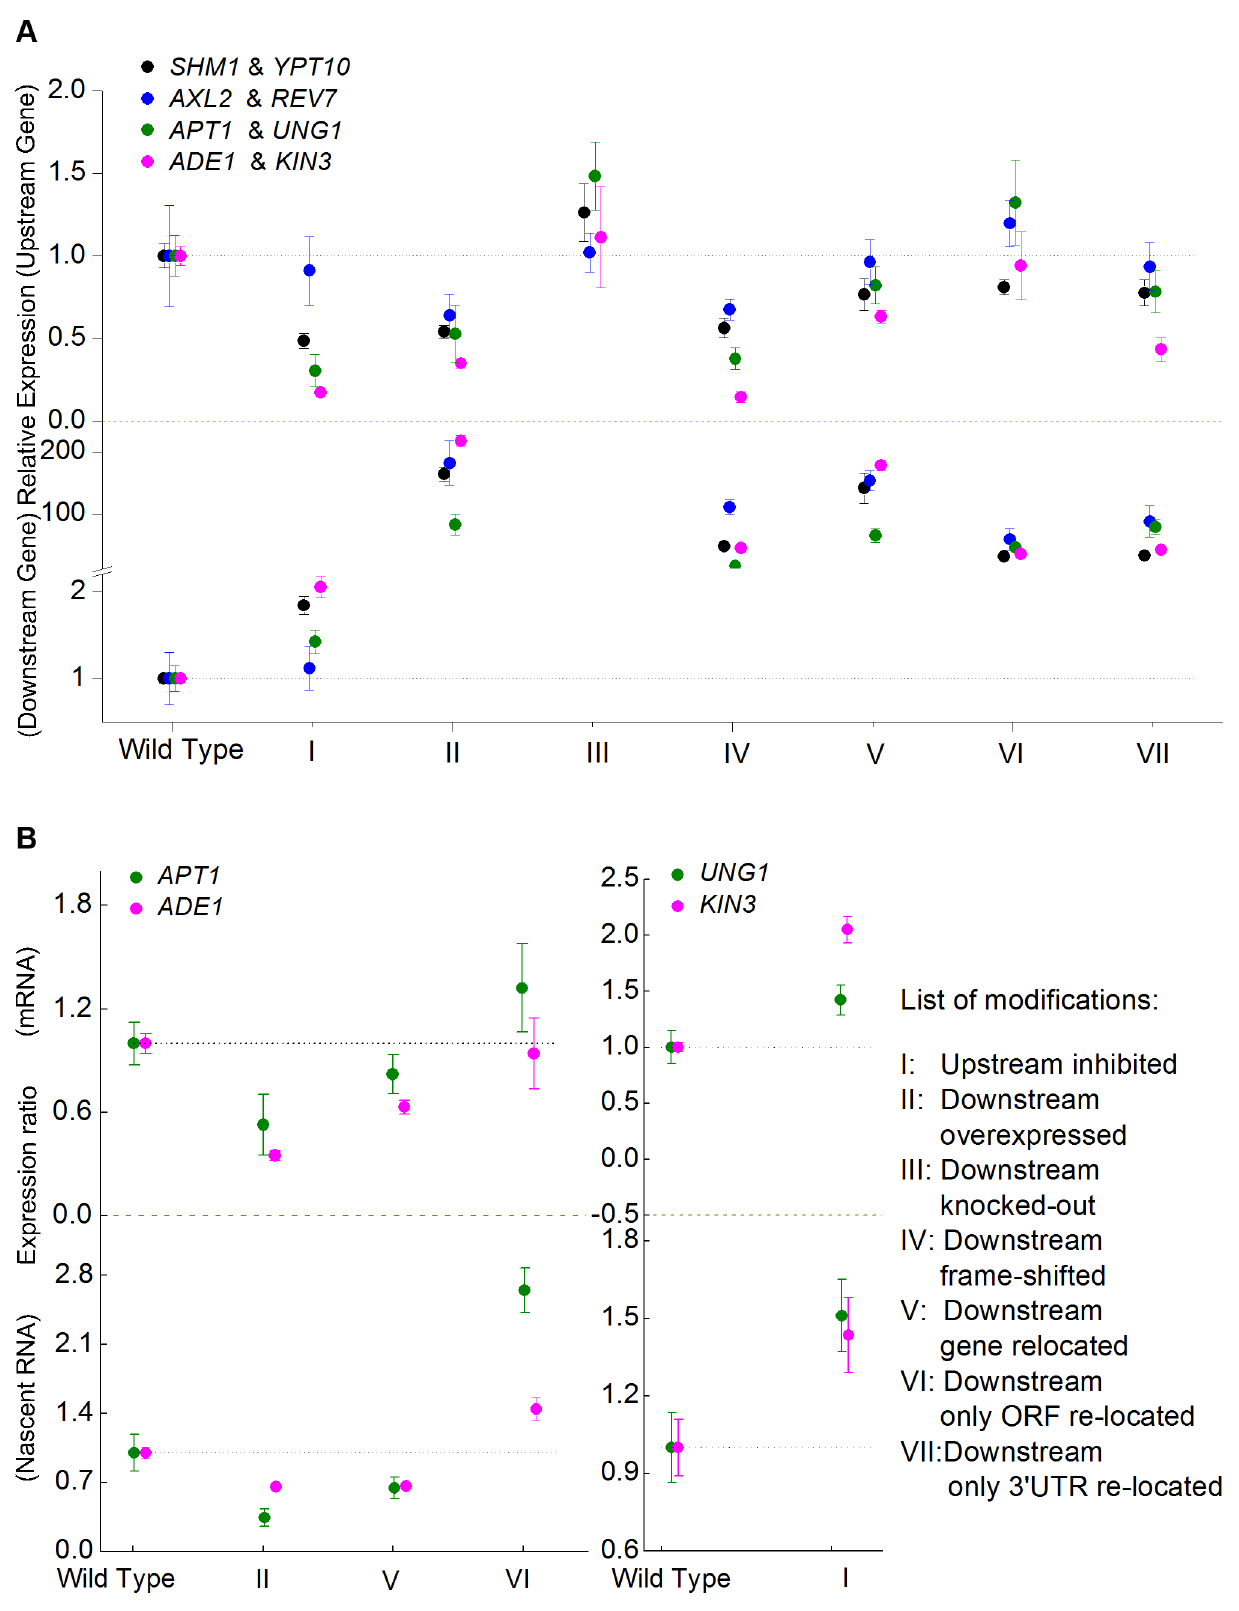
Figure 1. RT-PCR expression assay of convergent gene pairs located in cis or in trans . ( A ) Expression levels of four pairs of convergent genes with overlapping 3 9 -UTRs in wild type yeast, or when the upstream (group I) or the downstream (groups II–VII) genes were modified by: (I) inhibition of gene expression; (II) over-expression; (III) gene knock-out; (IV) frame-shift of the ORF; (V) re-location of the entire ORF and 3 9 -UTR; (VI) re-